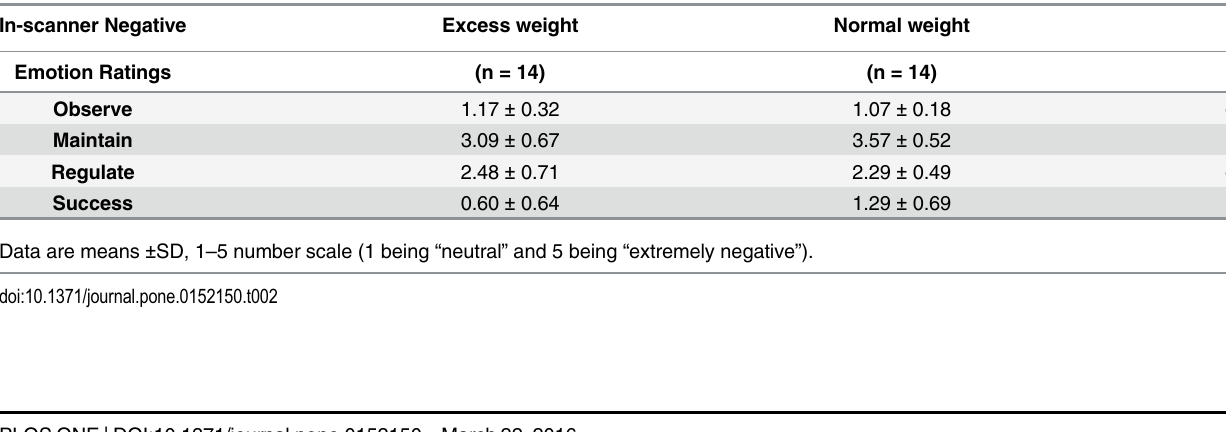
Table 2. In-scanner Negative Emotion